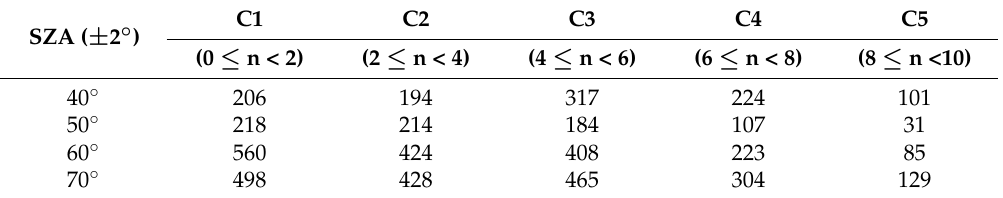
Table 1. Number of observation for cloud modification factor (CMF) calculation with respect to solar zenith angle (SZA) and cloud cover (n) during the period of 2006–2010.